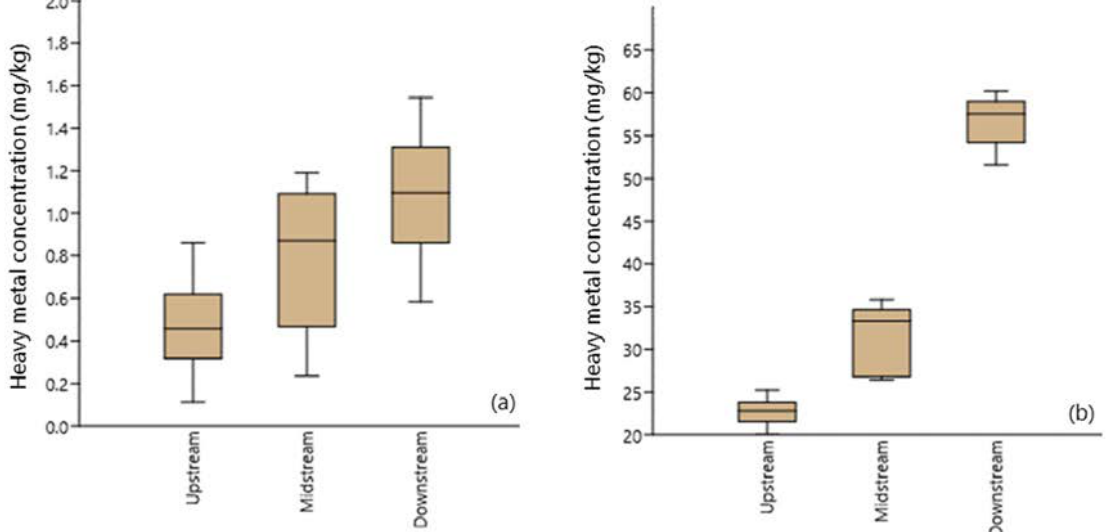
Fig. 3: Spatial distribution of Cd (a) and Pb (b) in riverine sediment from Ciliwung River